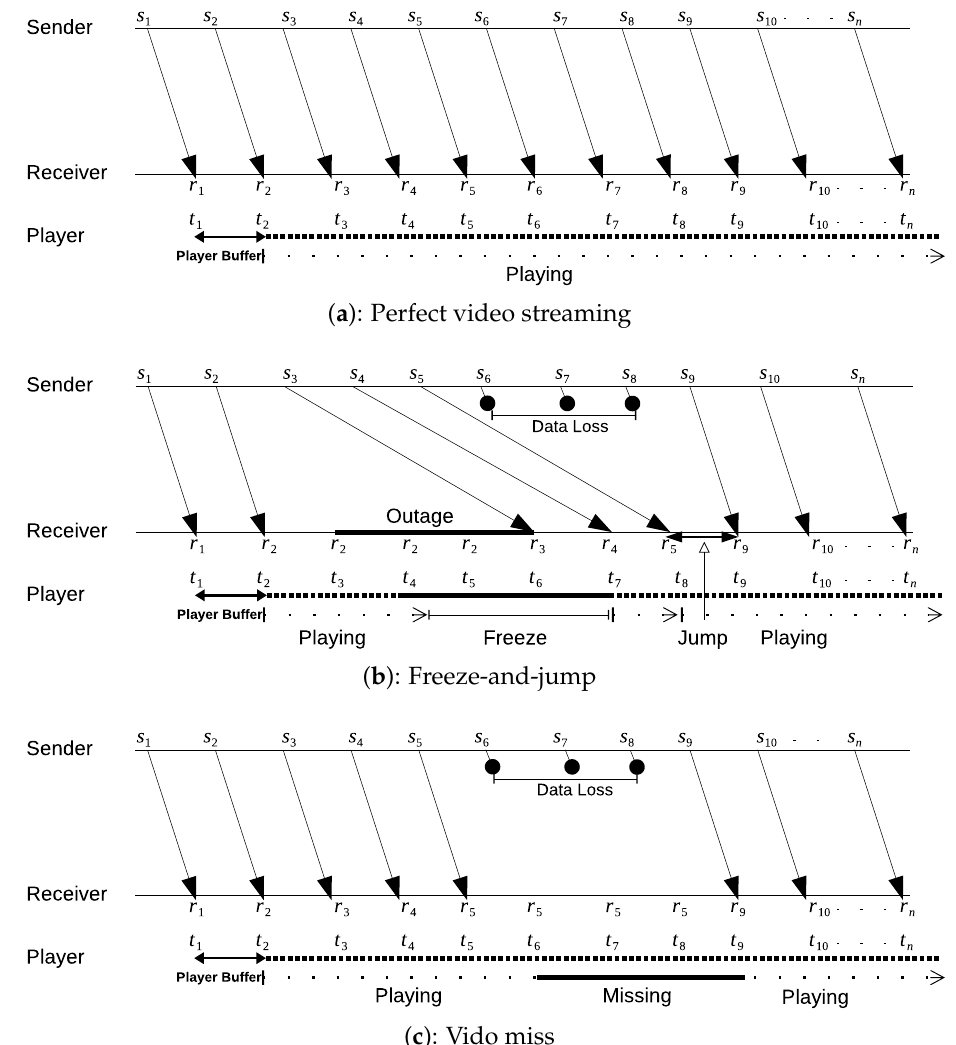
Figure 1. Description of ( a ): perfect video streaming; ( b ): video freeze-and-jump; ( c ): video